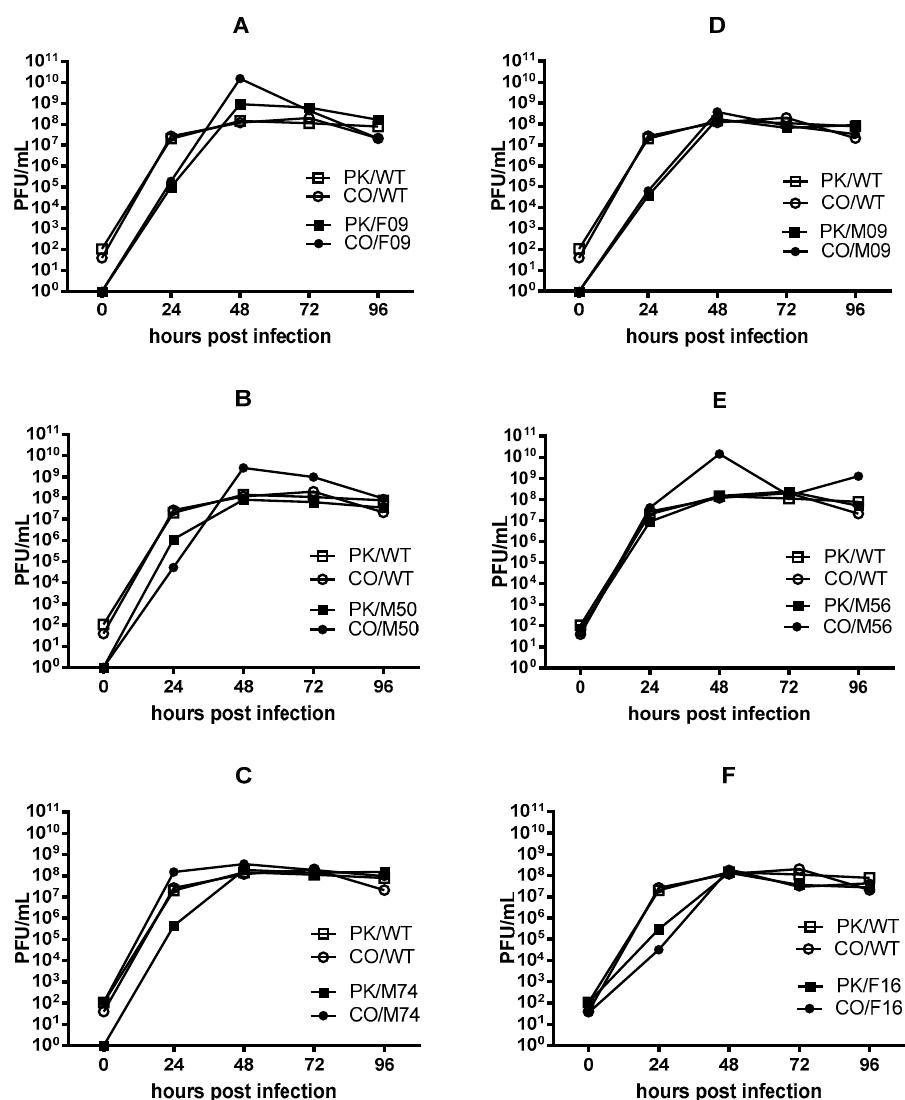
Figure 3. Multistep growth curves for escape viruses. MDCK cells were infected with a low MOI (0.001) of virus and the number of plaque forming units (PFU) present in the supernatant determined at various timepoints. The PK/WT and CO/WT growth curves are shown in each panel using open squares and circles respectively. The growth curves for the escape viruses are displayed as filled symbols. Growth curves for viruses generated using sera from the 2003 vaccine recipients are shown in panels ( A – C ) and growth curves for viruses generated using sera from the 2011 vaccine recipients are shown in panels ( D – F ).